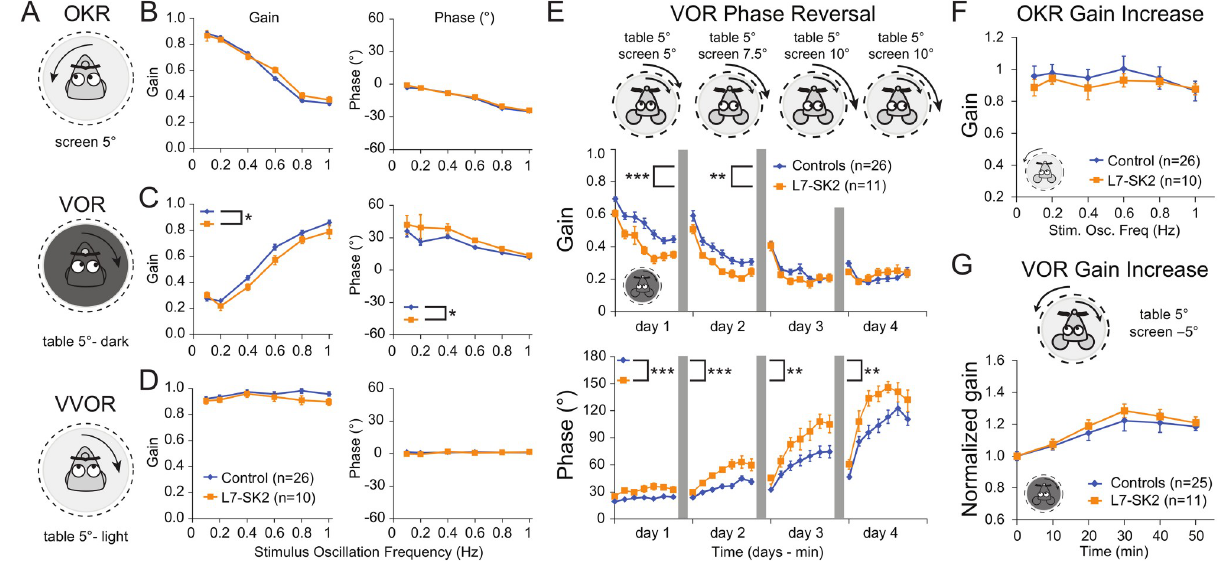
Fig 6. VOR baseline and adaptation. (A) Compensatory eye movements, aimed at minimizing retinal slip caused by visual and/or vestibular input, were used to test motor performance in L7-SK2 mice. L7-SK2 mice ( n = 10) and controls ( n = 26) were head-fixed on a table, and sinusoidal rotation (0.1–1.0 Hz) of the surrounding screen or the table evoked reflexive eye movements that were recorded by a table-mounted camera with IR lights. (B) Gain (measure of eye movement amplitude) and phase (measure of timing of the OKR evoked by rotation of the screen) did not differ between L7-SK2 and control mice. (C) The VOR, evoked by table rotation in the dark, was affected in L7-SK2 mice; both gain and phase were significantly impaired. (D) The combination of vestibular and visual input by rotation of the mouse in the light evoked the VVOR. With visual input, the VOR deficits in L7-SK2 were no longer present. (E) Next, mismatched visual and vestibular input was used to trigger adaptation of the eye movements in order to test motor- learning abilities in L7-SK2 mice. Training sessions (see cartoons) consisted of in-phase rotation of the vestibular and visual input with the same amplitude (5˚, 0.6 Hz) on the first training day (day 1, also referred to as VOR gain decrease) and increasing amplitude of the visual input on days 2, 3, and 4. This training induced a reversal of VOR phase (from head to left = eyes to right to head to left = eyes to left), probed by VOR recordings in the dark (plotted data). L7-SK2 mice reversed their VOR phase faster than controls, with significantly higher phase values on all days. (F) Directly following the phase-reversal training, the OKR was probed again to determine OKR gain increase. Both L7-SK2 and control mice were able to increase their OKR gain compared to pretraining values in B. (G) Finally, the ability to perform VOR gain increase was also tested by subjecting mice to out-of-phase visual and vestibular input (5˚, 0.6 Hz). Here, no effect of the mutation was observed in the ability to adapt the VOR gain. All data are mean ± SEM (note: for some data points, the error bars are obscured by the marker). � p < 0.05; �� p < 0.01; ��� p < 0.001. See also S4 Table. IR, infrared; OKR, optokinetic reflex; SEM, standard error of the mean; VOR, vestibulo-ocular reflex; VVOR, visually enhanced VOR.